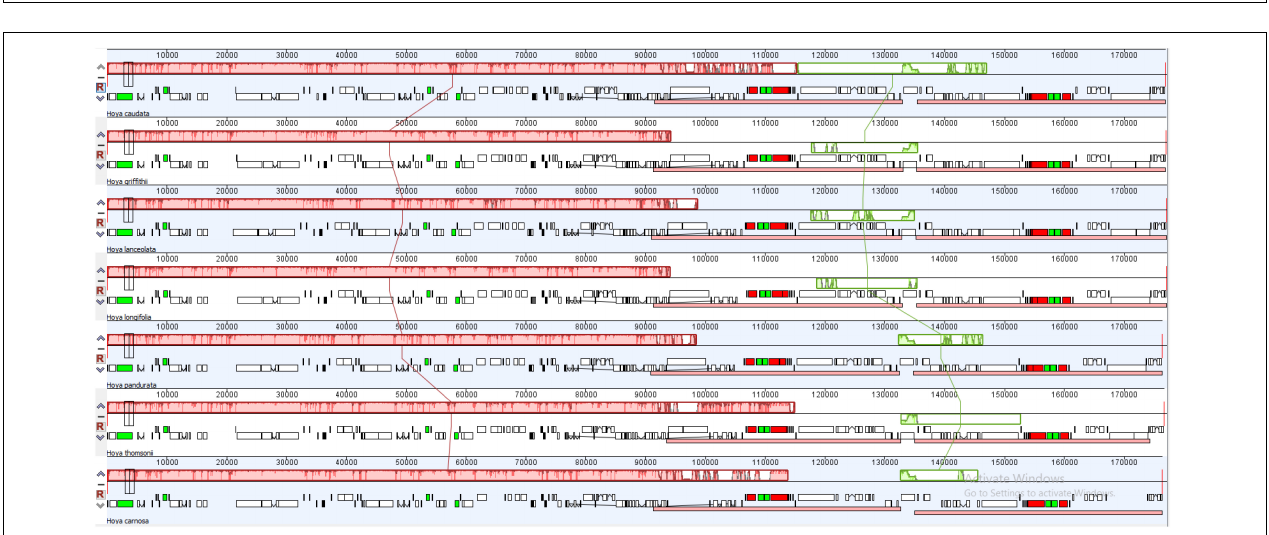
FIGURE 1 | The genome maps of (A) 27 Hoya species; (B) 4 Dischidia species. The genes inside the circle are transcribed in the clockwise direction and those outside in the anticlockwise direction. The different colors represent the genes of different functional groups. The thick lines denote the extent of IRa and IRb, which separates the chloroplast genome into LSC and SSC. LSC: large single copy; SSC: small single copy. Plastome structure variation.